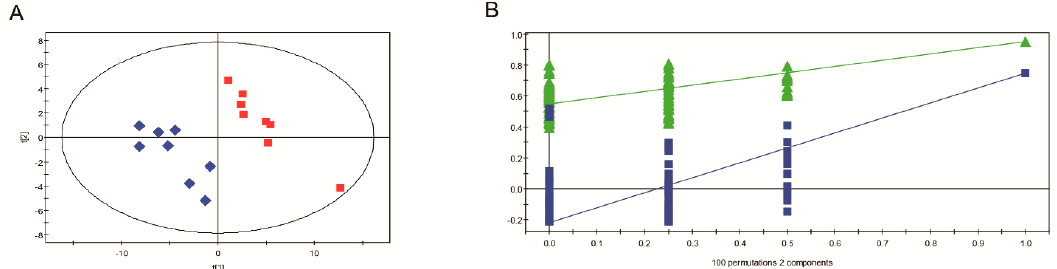
Figure 8. PLS-DA score plots derived from GC-MS data from isogenic strains GD-118P and GD-118P-V1 samples. A: PLS-DA score plot: GD-118P (red square) and GD-118P-V1 (blue diamond); B: Permutation test plot (100 permutations) derived from GC-MS data of GD-118P and GD-118P-V1 samples.